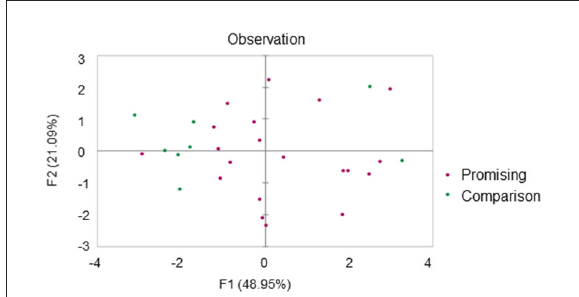
FIGURE8 Principal component analysis (PCA) for the researchers’ research performance corrected by their supervisors’ research performance. Twenty-eight researchers trained under seven prominent supervisors were selected. Purple and green dots indicate the promising and comparison young researchers,